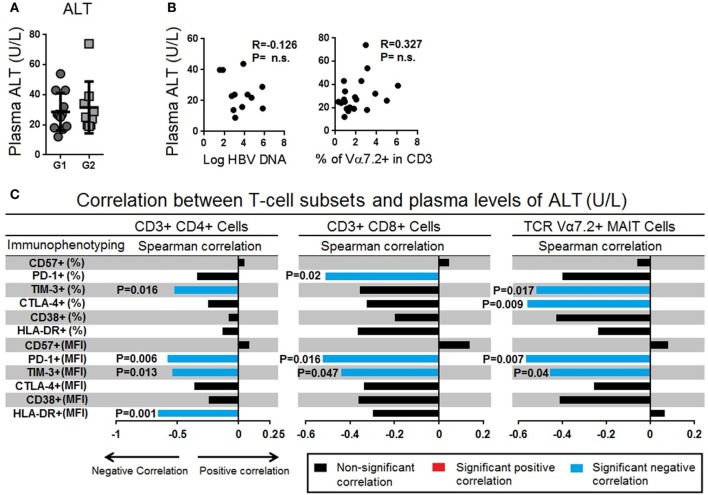
(A) Comparison of serum alanine transaminase (ALT) levels between chronic hepatitis B virus (HBV)-infected patients with HBV-DNAemia (circle) and without HBV-DNAemia (square). (B) Spearman correlation between serum ALT levels and frequencies of T cell receptor (TCR) Vα7.2+ CD161+ mucosal-associated invariant T (MAIT) cells. (C) Spearman correlation between frequencies and expression levels of CD57, PD-1, TIM-3, CTLA-4 CD38, and HLA-DR with serum level of ALT. The bar represents the strength of association (r values) where red bar represents significant positive correlation, blue bar represent significant negative association and black bar represents P value > 0.05 (non-significant association) (<0.05, **<0.01, ***<0.001, and ****<0.0001).